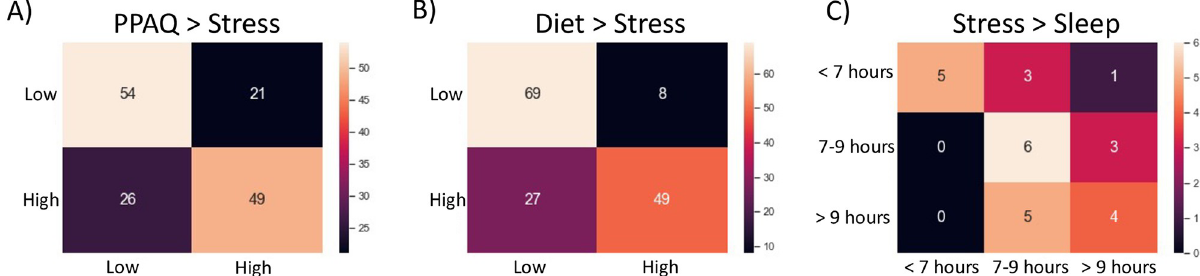
Fig 2. Confusion matrices of classifier performance. Classification models predicting A) stress class from physical activity; B) stress class from diet; and C) amount of sleep from perceived stress.